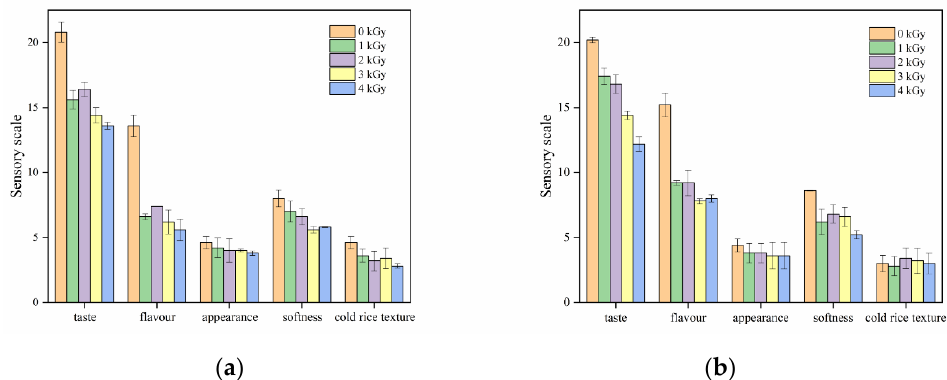
Figure 5. Sensory evaluation of cooked rice treated with various irradiation doses. ( a ) LM rice, ( b ) HM rice.